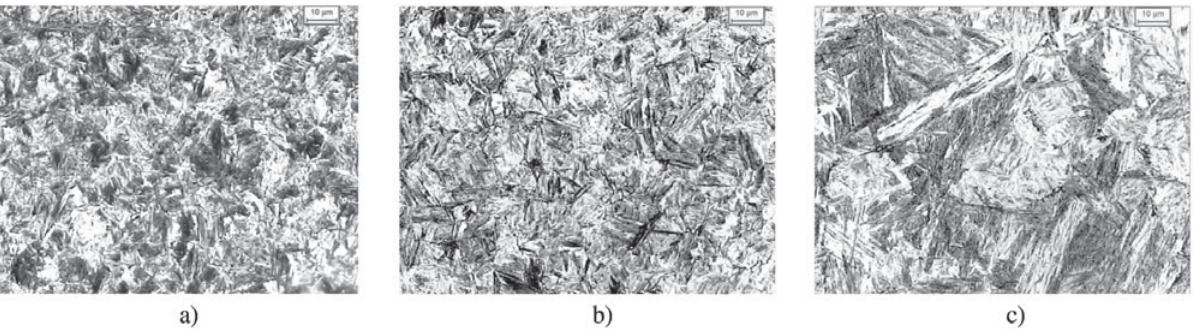
Figure 3. Optical micrographs (1000 ×) of samples austenitized at different temperatures prior to quenching: (a) 900 °C; (b) 1000 °C; (c) 1100